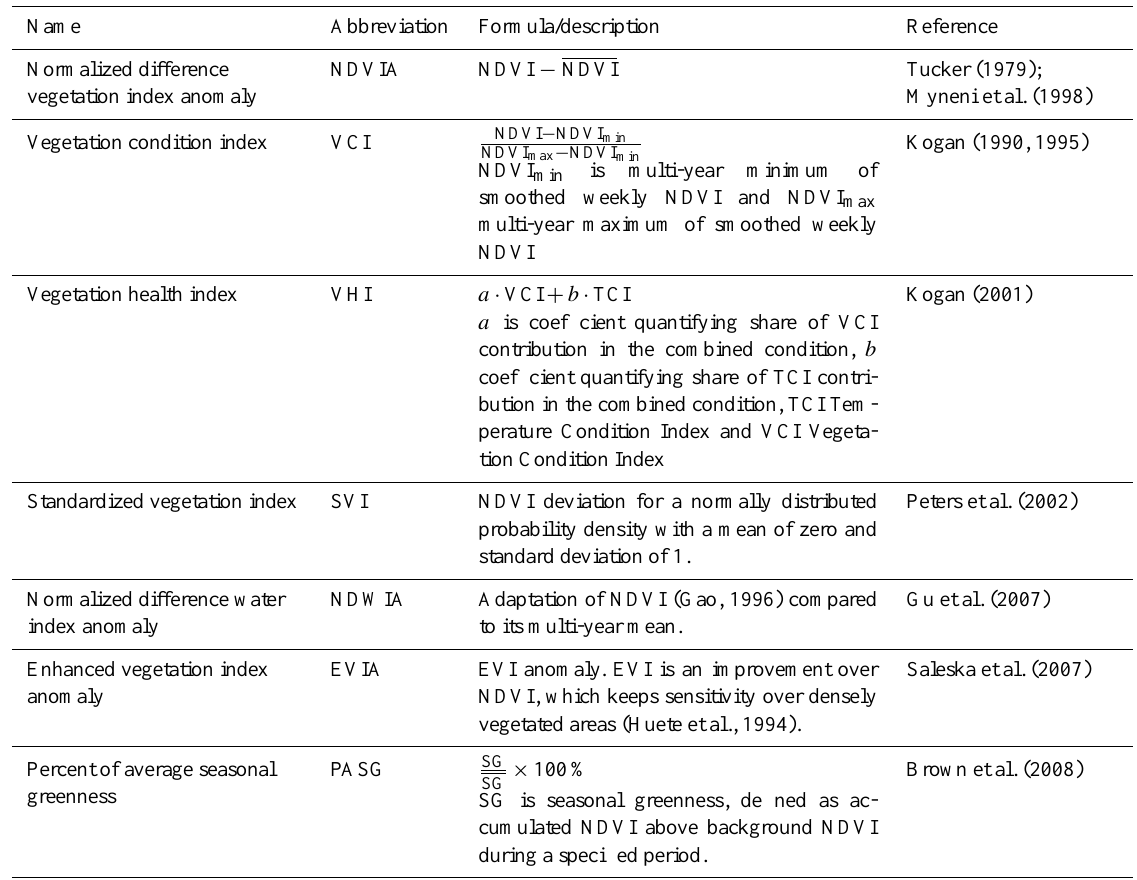
Table B3. Vegetation drought